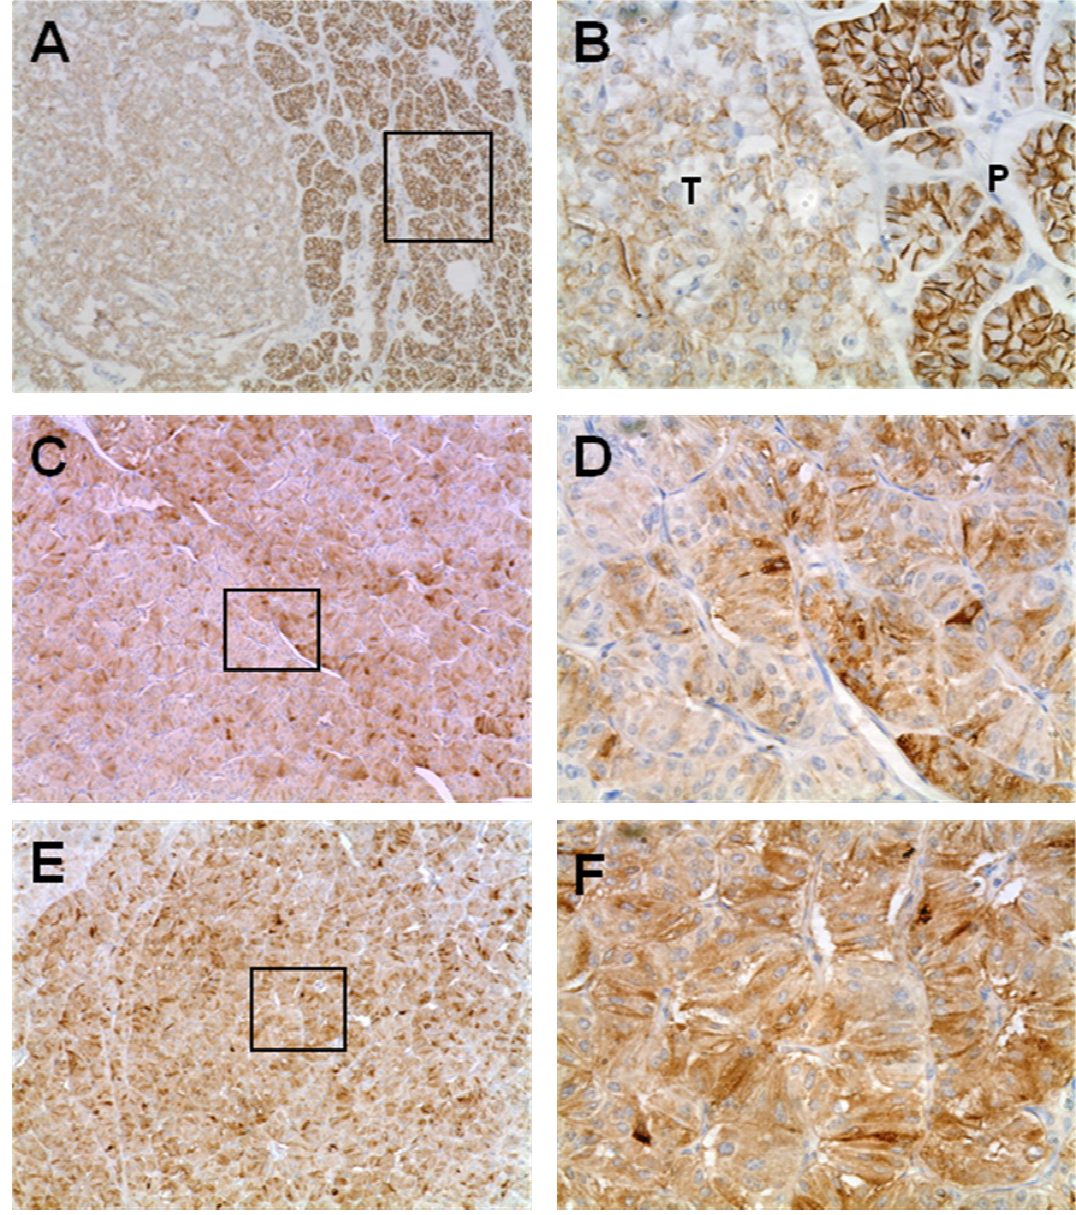
Figure 2. IHC staining for E-cadherin, Snail and Twist in human PNETs. Loss of E-cadherin was seen in many PNETs, as shown in (A) and (B). Note the loss of in tumor tissue (T) compared to normal membranous staining of exocrine tissue in normal pancreas (P). This loss of E-cadherin was accompanied with strong expression of Snail (C and D) and Twist (E and F), (A, C, E, 10×; B, D, F 40×